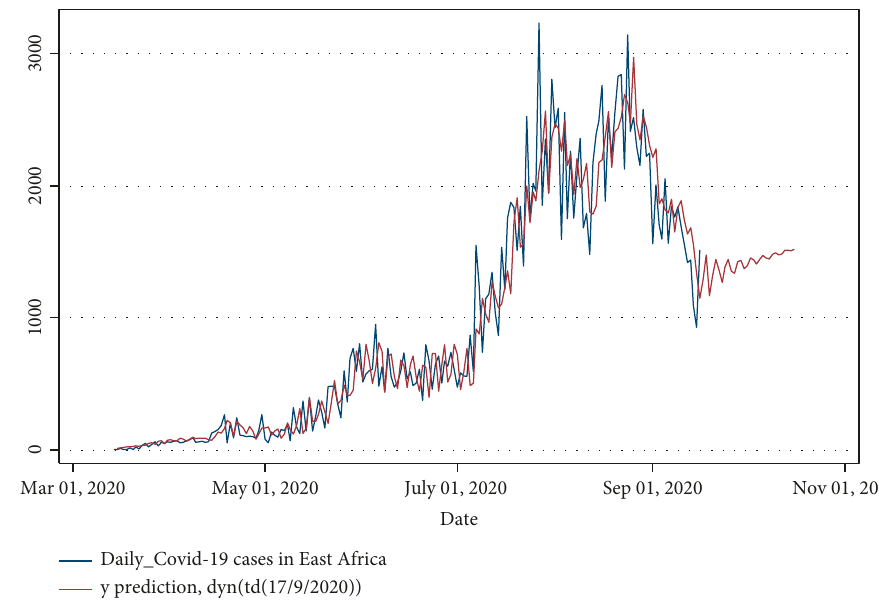
Figure 3: The plot of actual confirmed cases with the prediction result of the ARIMA model for East Africa.